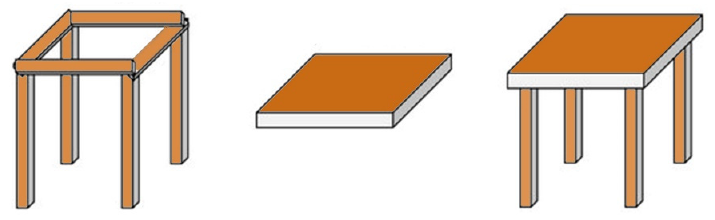
Figure 11. Production process diagram of “Table”.